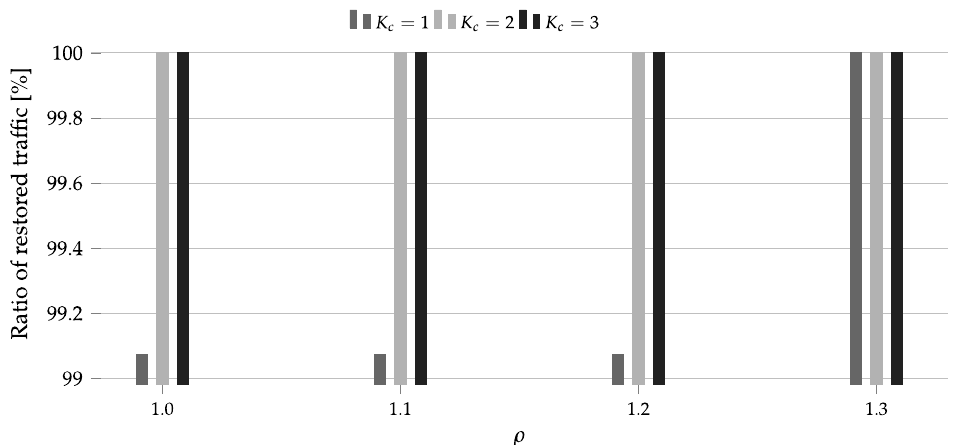
Figure 3. Ratio of the restored traffic for PL12 and 5 Tbps as a function of the amount of additional resources ρ .